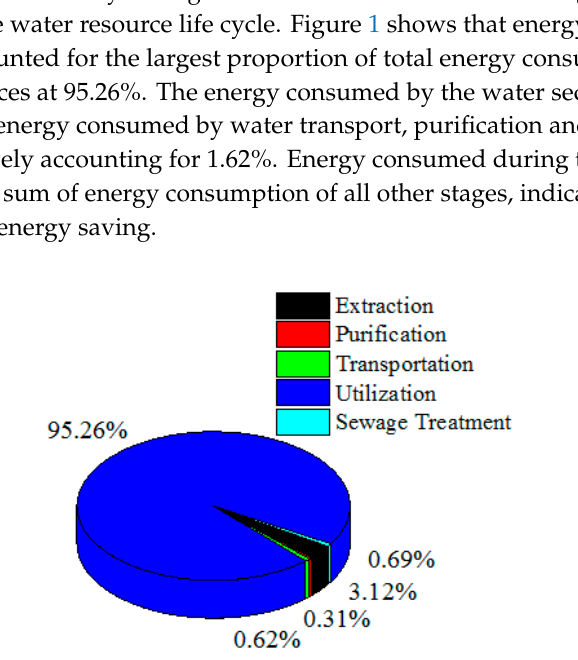
Figure 1. Proportion of energy consumed during each stage of the entire life cycle of water resources in Ordos, China, during 2017.